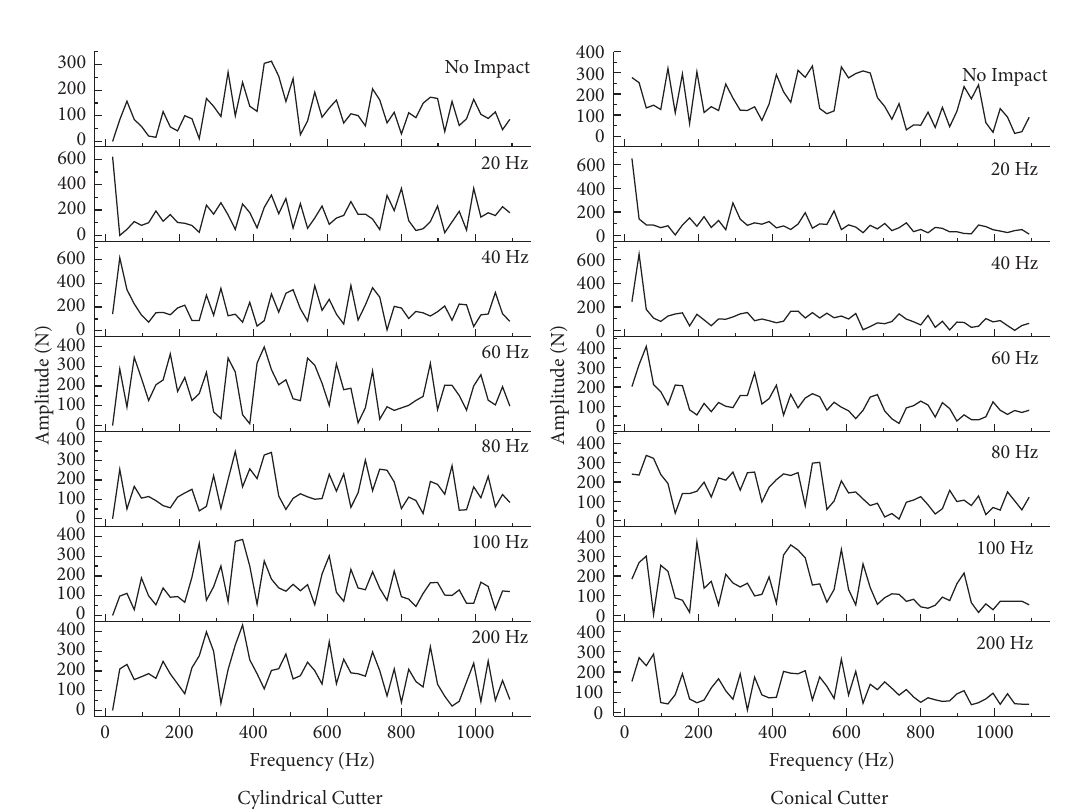
Figure 4: WOB frequency